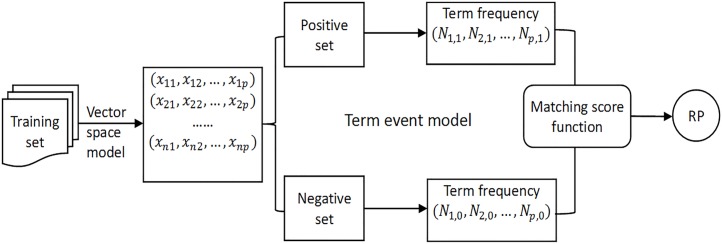
Block diagram of RP.